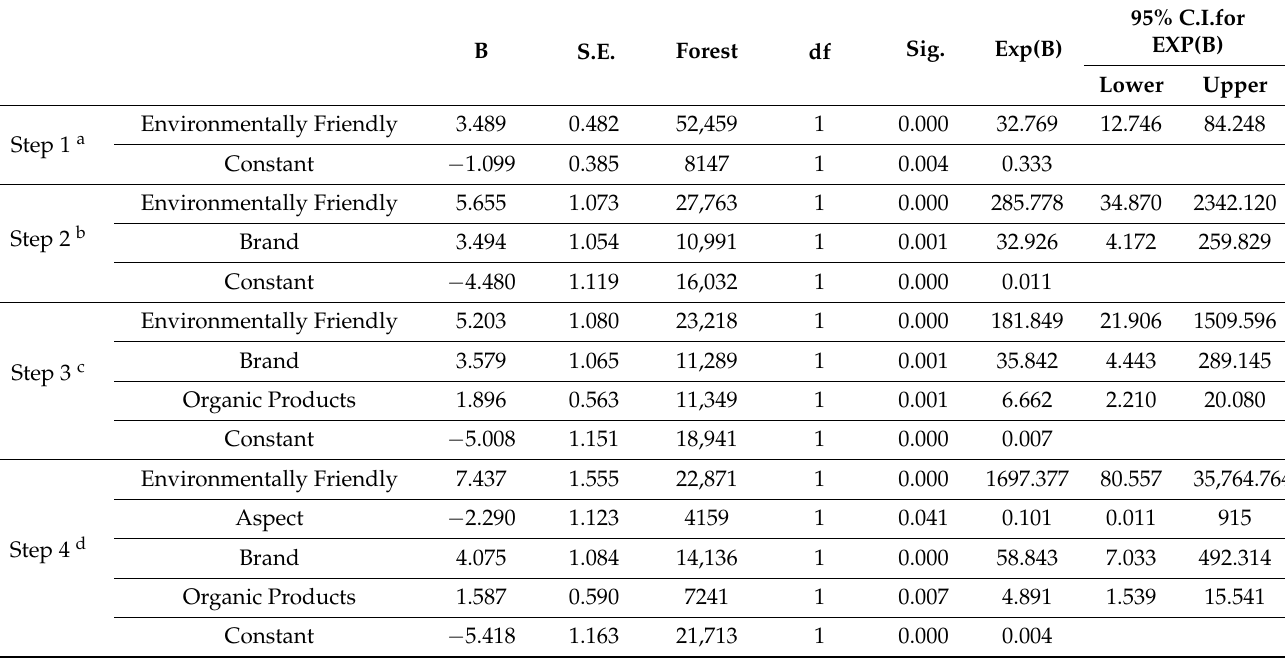
Table 4. Italian sample. Output of logistic regression by using Forward Stepwise (Likelihood Ratio) Method for selecting variables in the